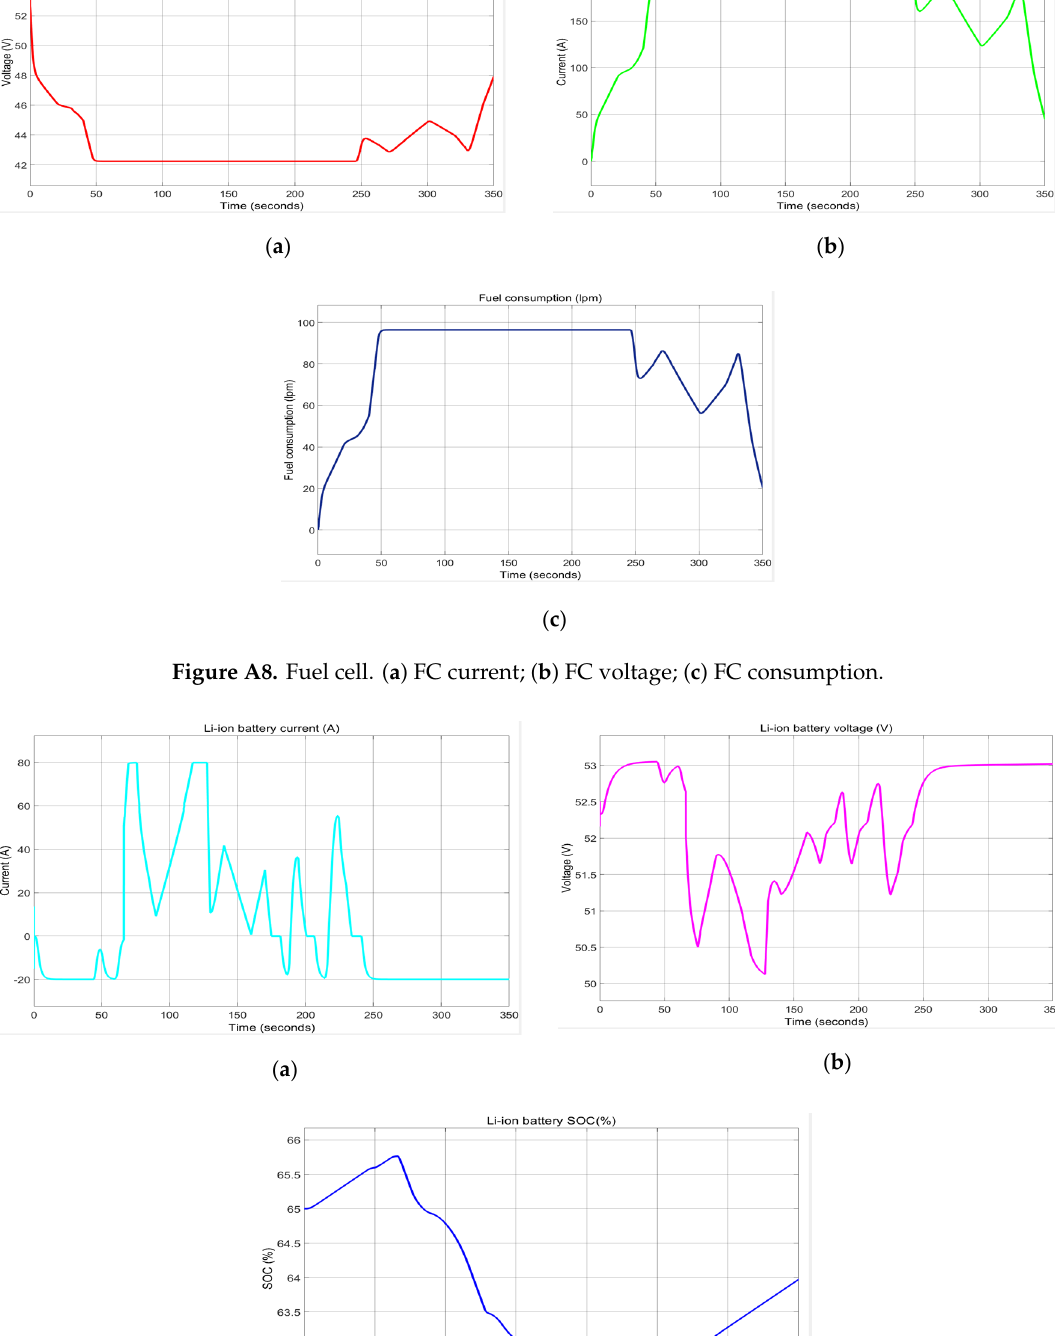
Figure A7. SMCAR HEV power-equivalent consumption minimization EMS.